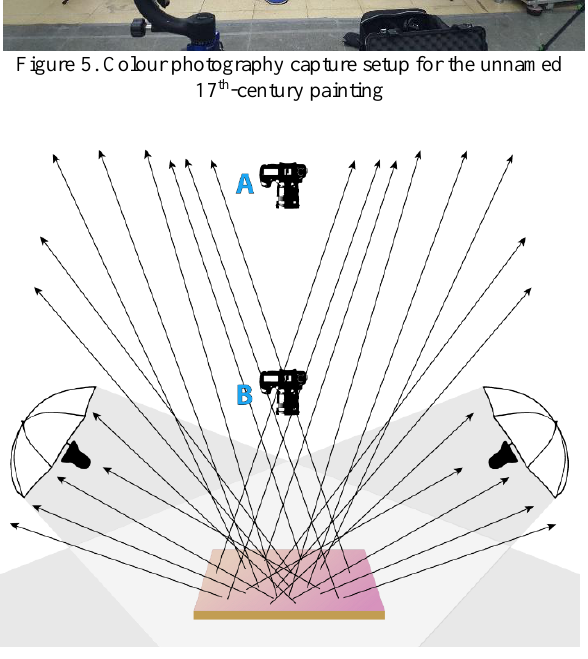
Figure 6. Positions of photographic (A) vs. photogrammetric (B) setups in the capture of painted